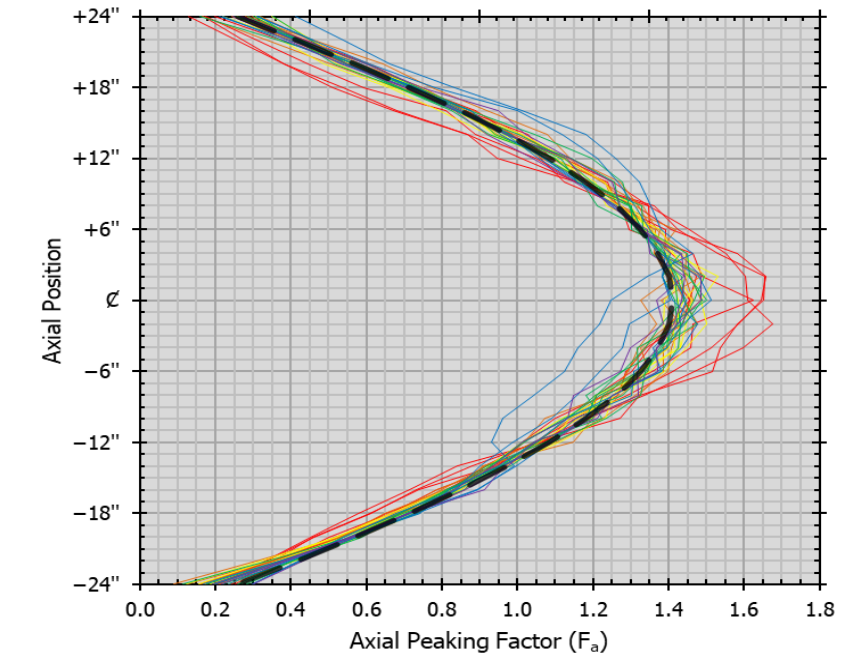
Figure 5. Selected Axial Profiles with Higher